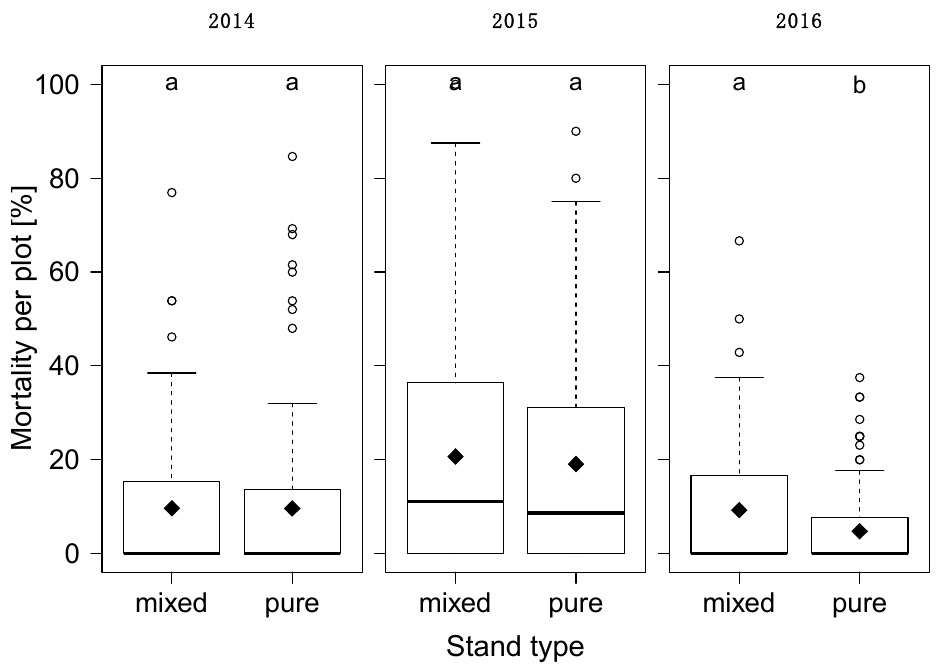
Figure 2. Poplar mortality across sites for mixed and pure stands in the first three years after planting. Mean values are marked by (cid:7) . Different letters (a, b) indicate significant differences between the stand types at significance level p < 0.05.